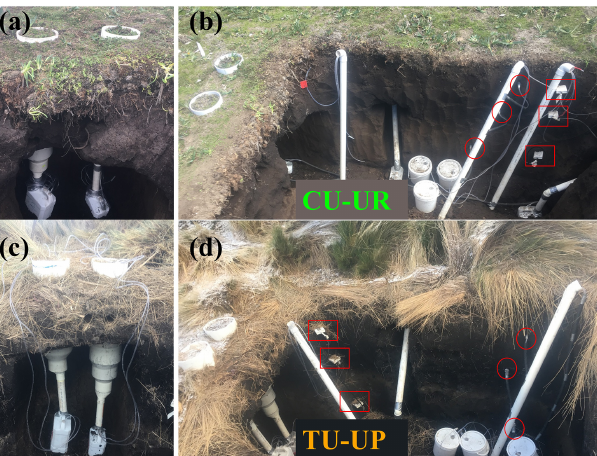
Figure 2. Photos of the soil pits under cushion-forming plants (CU- UR, a , b ) and tussock grasses (TU-UP, c , d ) showing the fluxmeters ( a , c ); water content reflectometers (red rectangles) and suction cups (red circles) ( b , d